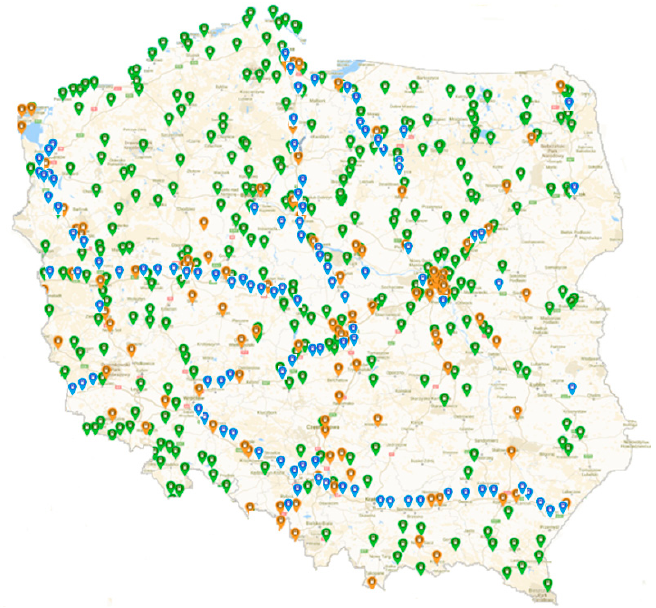
Figure 10. Map of charging points in Poland—as of March 31, 2021 according to the Act of January 11, 2018 on electromobility and alternative fuels.